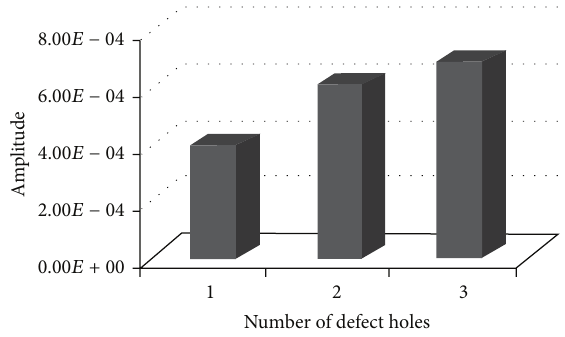
Figure 10: Defect amplitude variations according to the defect